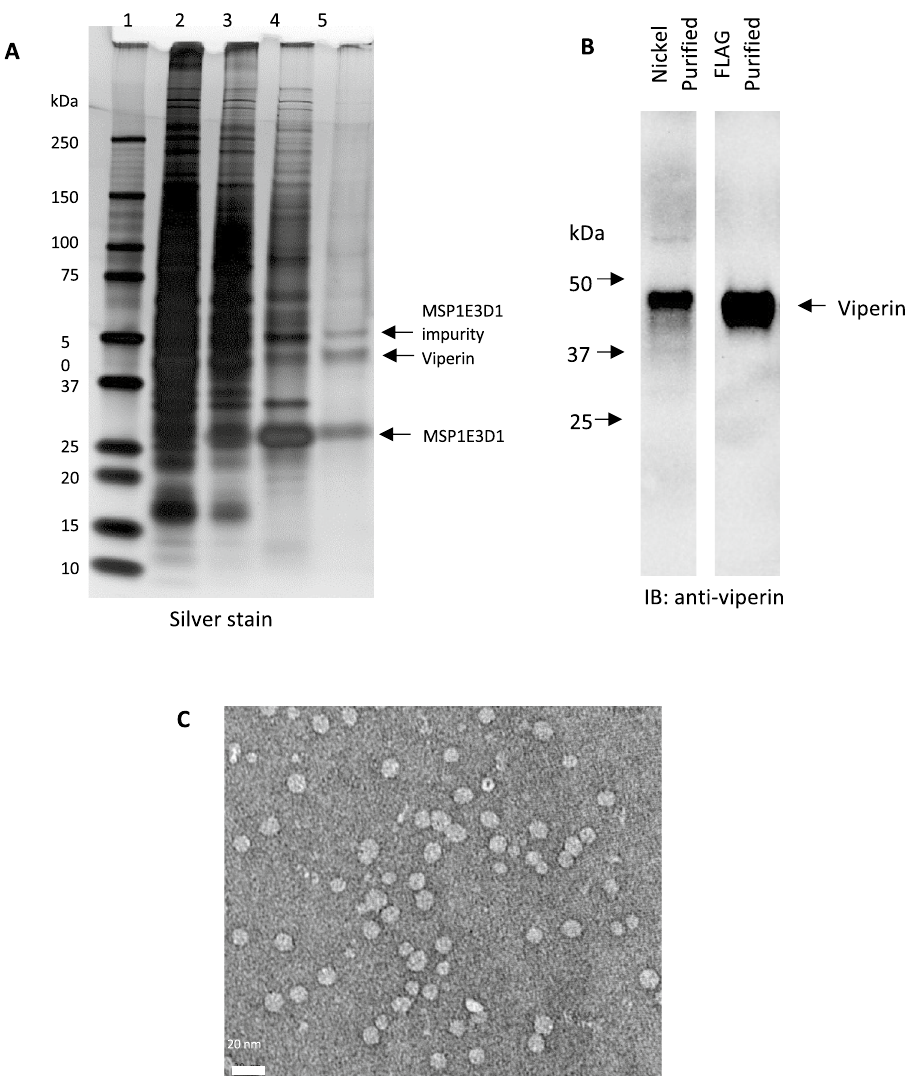
Figure 2. ( A ) SDS PAGE (silver-stained gel) illustrating a typical purification of viperin: lane 1 : molecular weight ladder; lane 2 : total cellular protein; lane 3 : clarified cell lysate prior to addition of MSP; lane 4 : nanodiscs purified by nickel-NTA affinity chromatography; lane 5 : viperin nanodiscs purified by FLAG affinity chromatography. ( B ) Immunoblot analysis (blot immunostained for viperin) of the nanodiscs after purification by nickel-NTA affinity and FLAG affinity chromatography confirms the identity of the enzyme. (The uncropped image for panel B is shown in Figure S1) ( C ) Negative stain TEM image of the viperin nanodiscs after purification by FLAG affinity